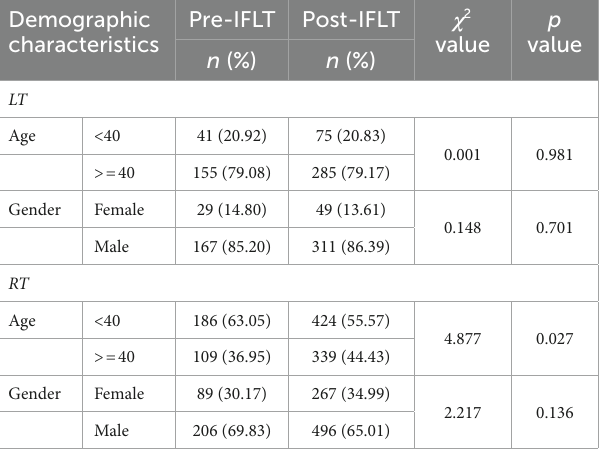
TABLE 2 Demographic characteristics of organ transplant recipients in the pre- and post-IFLT periods. Demographic characteristics